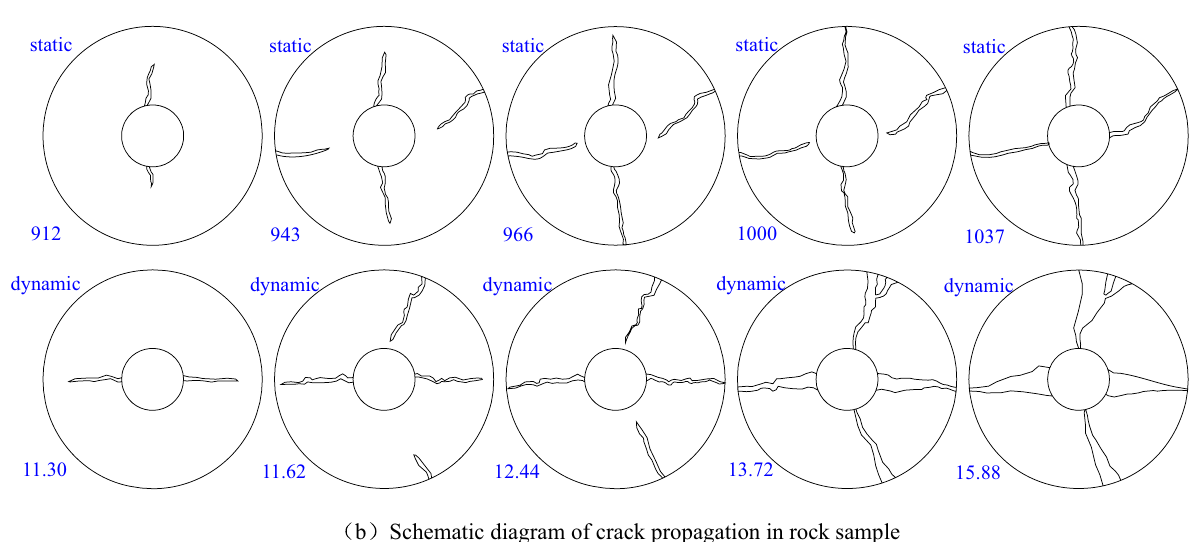
Figure 5. Damage and failure process of circular granite under radial load (The inner diameter of the rock samples are all about 12 mm in ( a – b